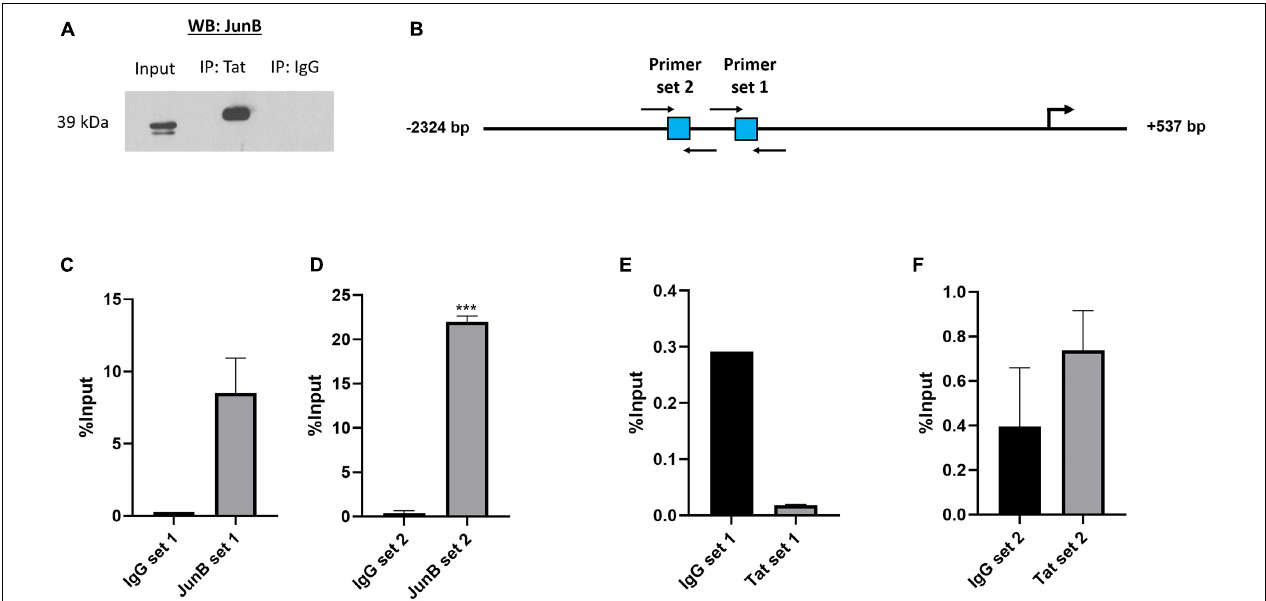
FIGURE 3 | HIV-1 Tat and JunB form protein to protein associations and occupy the c-MYC promoter at two AP-1 binding sites. HT1080 cells were transfected with both 500 ng HIV-1 Tat expression vector (pcDNA-Tat) and 500 ng JunB expression vector (pCMV-JunB). (A) The cell lysate was incubated with anti-HIV-1 Tat antibody (ab43014, Abcam, United Kingdom) and pulled down using protein A agarose beads (Roche, Germany). Western blot was carried out using an anti-JunB antibody (Santa Cruz, United States) The goat-anti-rabbit secondary antibody (Bio-Rad, United States) was used as a negative control (lane 3). (B) Diagrammatic representation of the c-MYC promoter depicting the location of the two AP-1 sites in square blocks and the positions of the forward and reverse primers used for the ChIP assay are denoted by black arrows. (C–F) Bar graphs show qRT-PCR data using immunoprecipitated DNA obtained from ChIP with either anti-JunB, anti-HIV-1 Tat or anti-IgG (negative control) antibodies and amplified with the primers depicted in the diagram, error bars represent SD. Statistical significance determined using Student’s t -test in GraphPad PRISM 8, ∗∗∗ ( p < 0.001). The graphs are representative of at least three separate